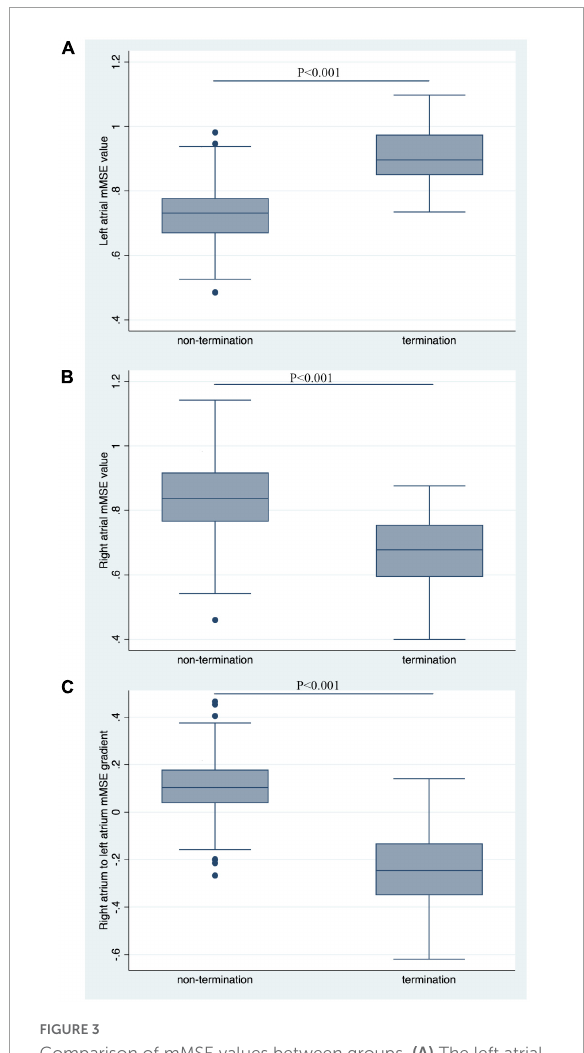
FIGURE3 Comparison of mMSE values between groups. (A) The left atrial mMSE value was significantly higher in the termination group than in the non-termination group, with a P -value for comparison < 0.001. (B) Non-termination had a higher right atrial mMSE value than the termination group, with a P -value for comparison < 0.001. (C) RA-to-LA mMSE gradient was significantly higher in the non-termination group than in the termination group ( P <